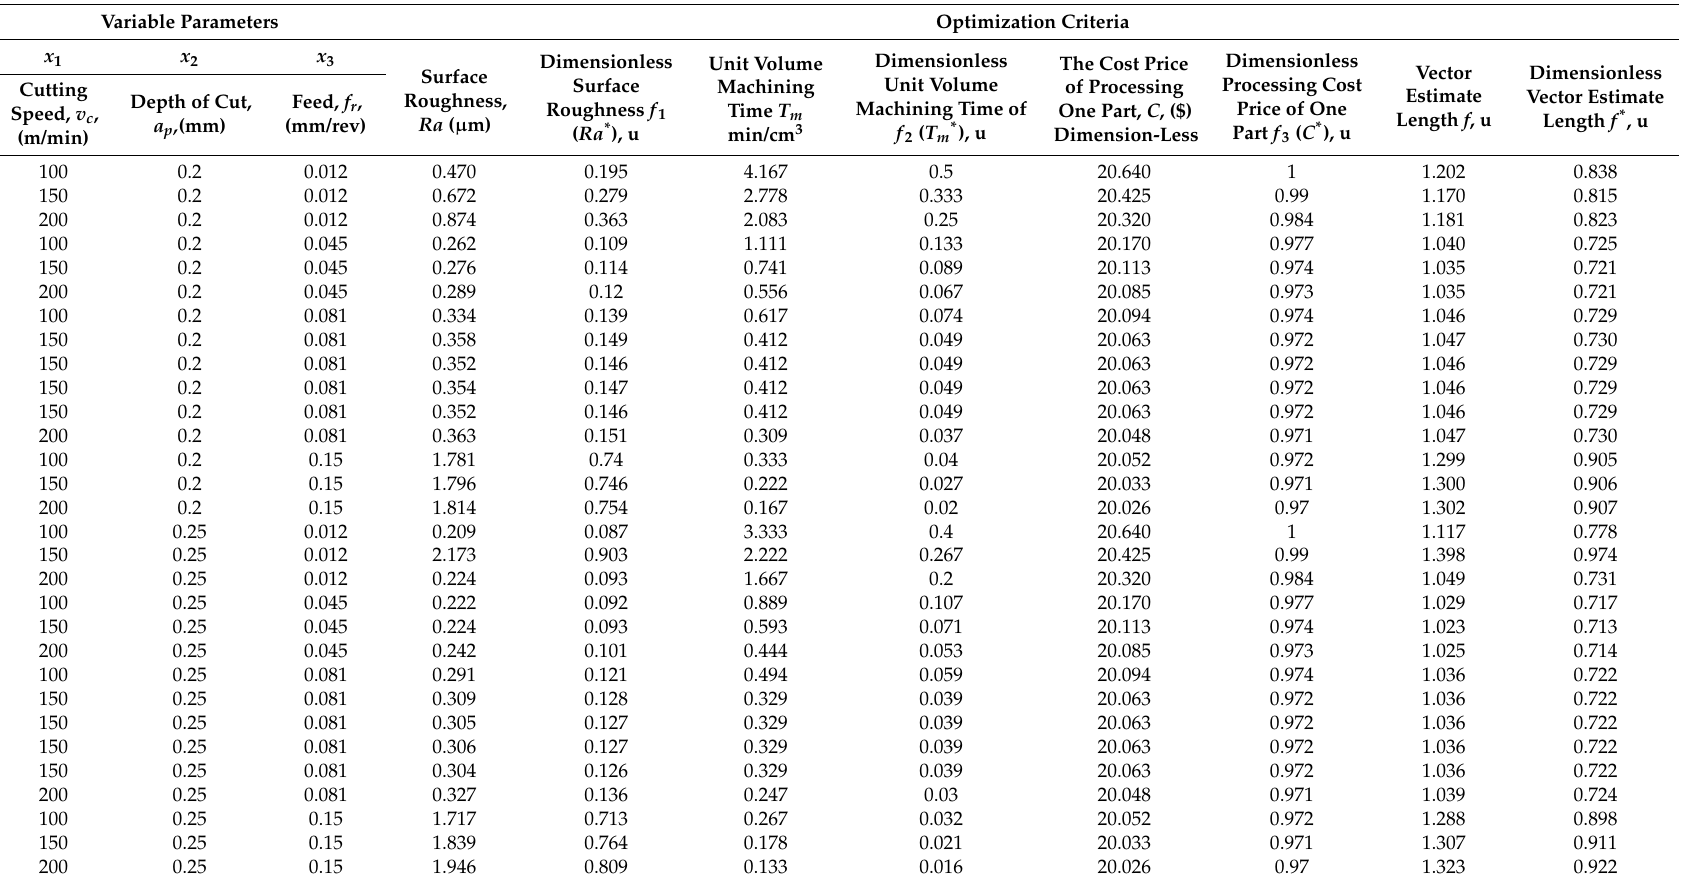
Table 8. A selection of the optimization criteria parameter value set for the variable parameters of machining of a workpiece hardened with ECAP-6. Variable